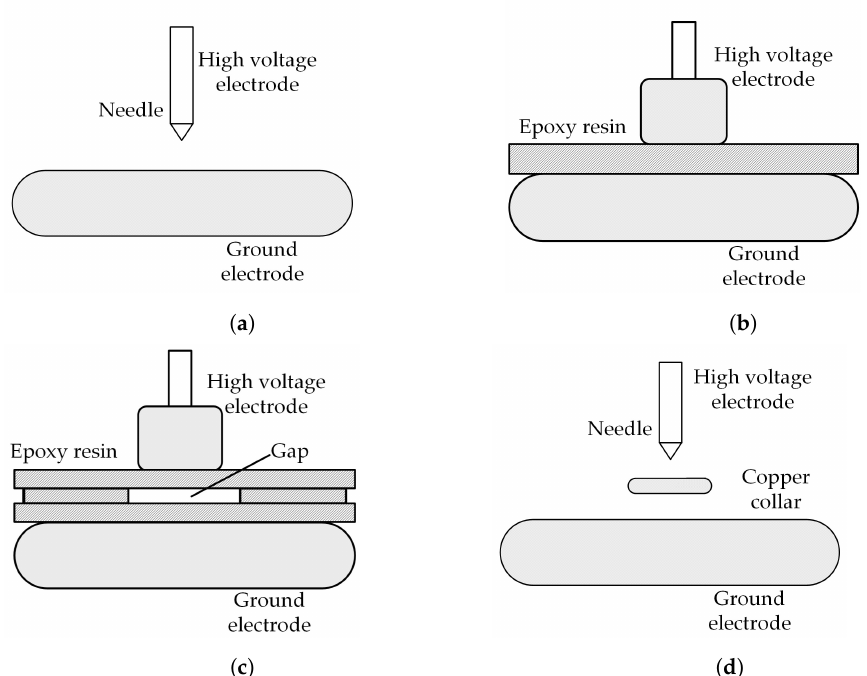
Figure 5. Typical PD defect models: ( a ) point discharge; ( b ) surface discharge; ( c ) air gap discharge; ( d ) suspended discharge.